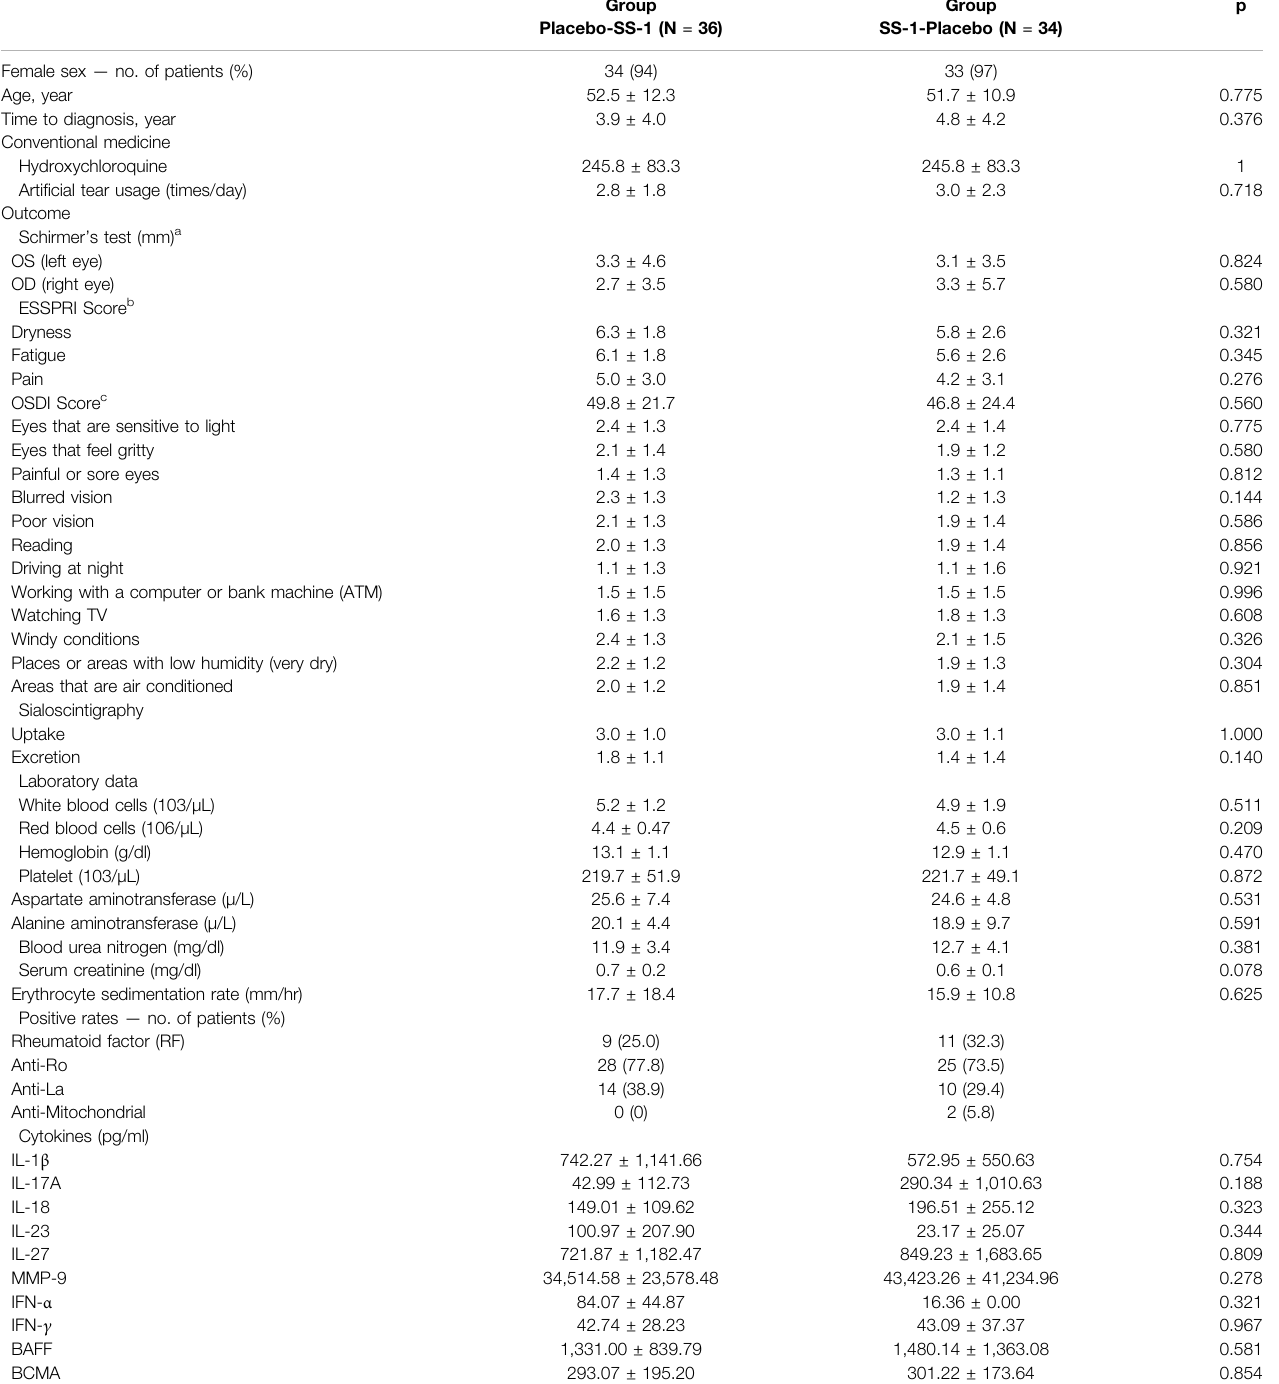
TABLE 1 | Baseline characteristics of the SS-1 trial for Sjögren ’ s syndrome